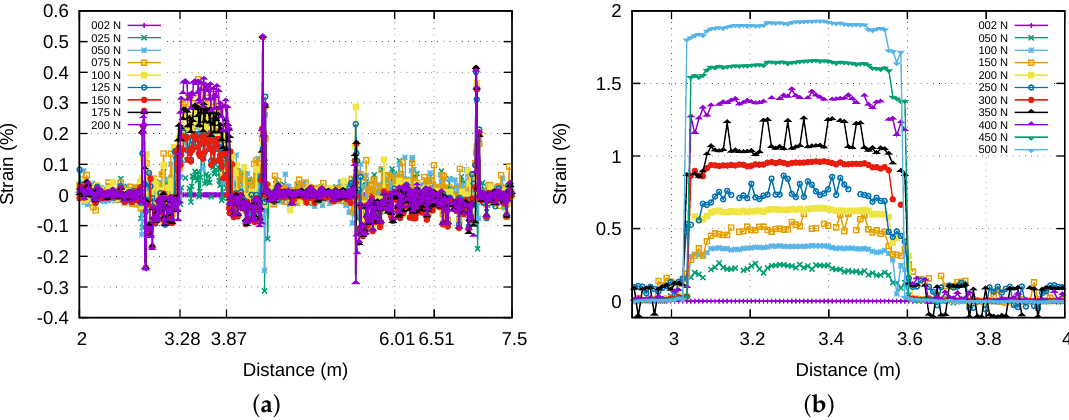
Figure 13. Strain measured by optical fibres inserted in straps. In ( a ) only the polymer film is bonded to clamping parts. In ( b ) the optical fibre is bonded with the polyester coating to polymer film while the polymer film and the strands are bonded to clamping parts.